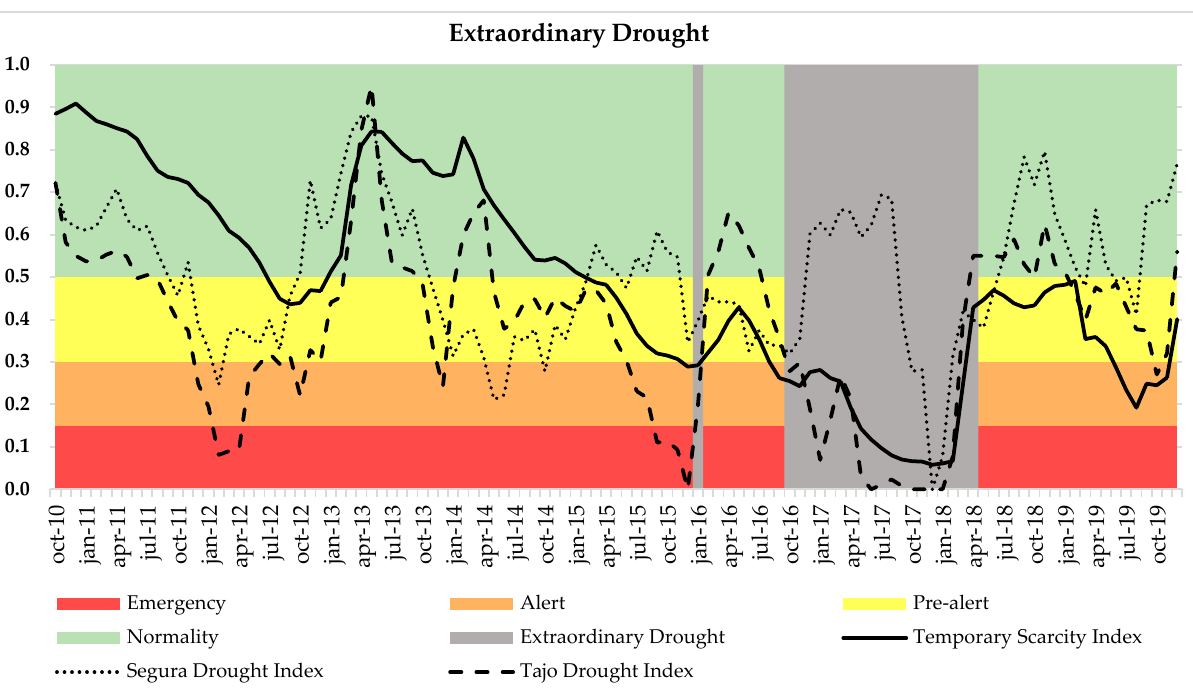
Figure 13. Evolution of the extraordinary drought in the Segura Basin, period October 2010–December 2019. Source: own elaboration based on [64].